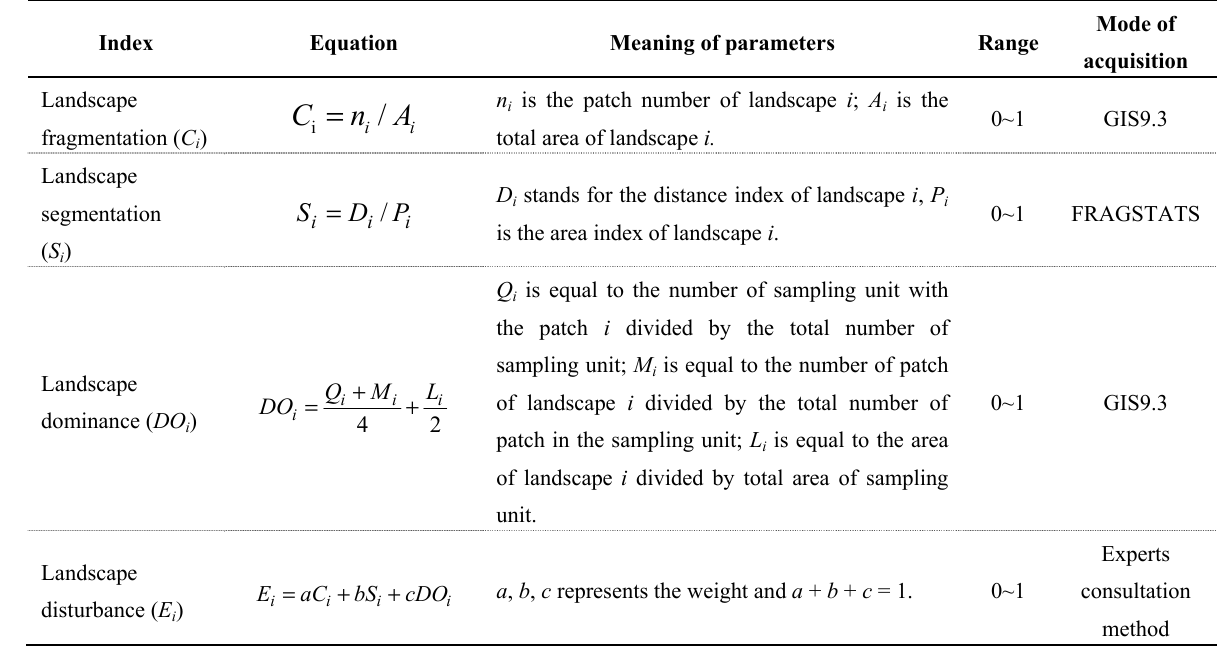
Table 2. Calculation method of the landscape disturbance